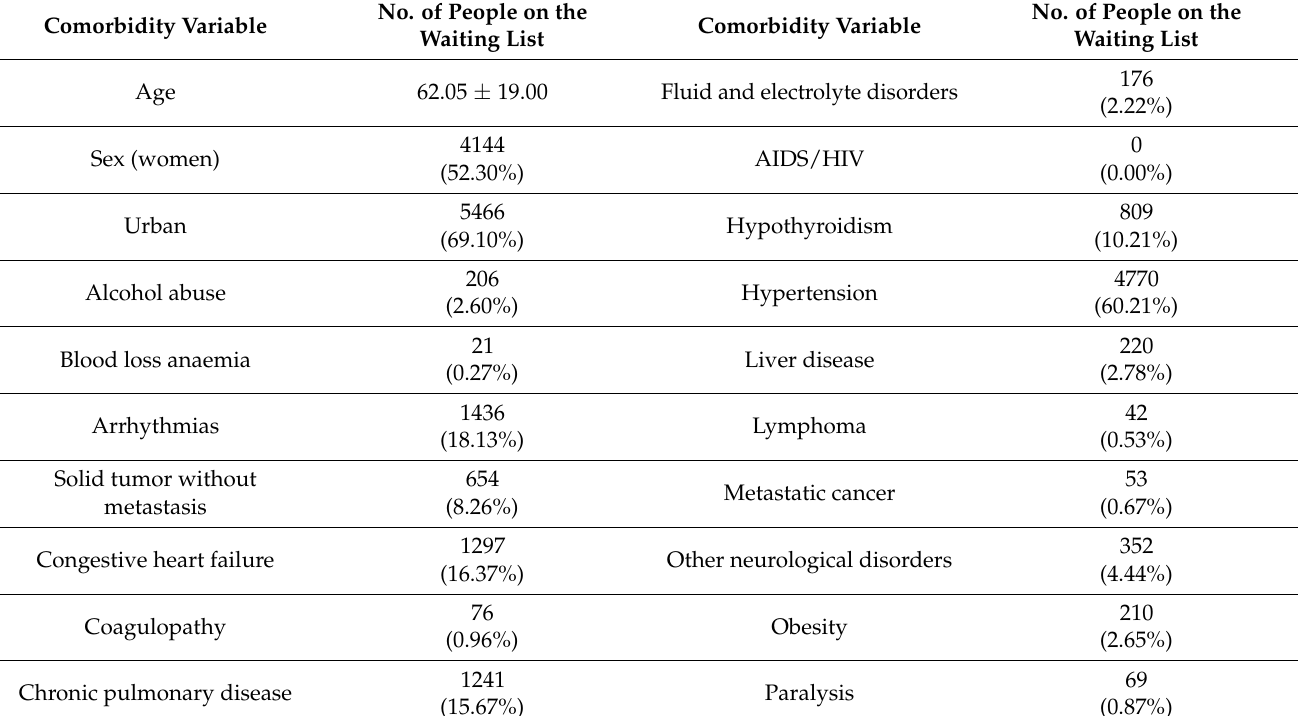
Table 6. Characteristics of the population waiting for keratoplasty in terms of comorbid factors in the years 2013–2017 in